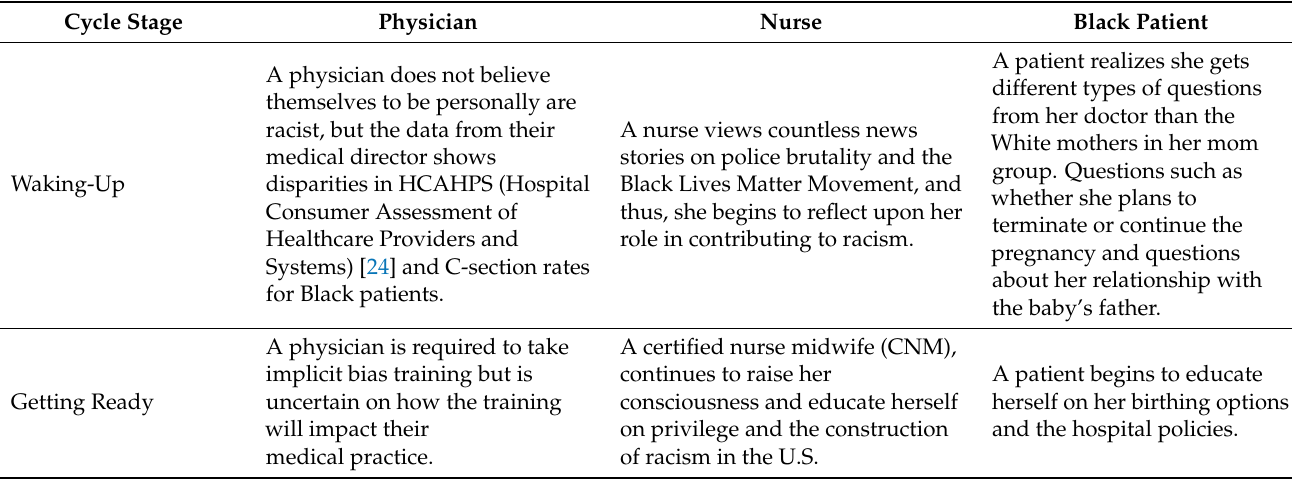
Table 3. Examples of Individuals Moving through the